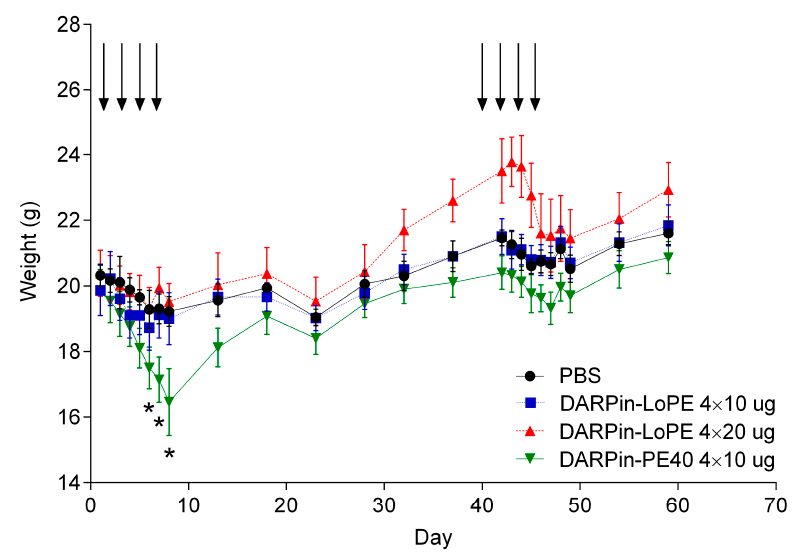
Figure 3. Mean weight of mice in different groups. The days of the targeted toxins injections are indicated with arrows (4 injections per course, 2 courses). PBS, mice treated with phosphate-buffered saline (control group); DARPin-LoPE 4 × 10 µg, mice treated with 10 µg DARPin-LoPE for 4 doses every other day (40 µg per course, 80 µg total); DARPin-LoPE 4 × 20 µg, mice treated with 20 µg DARPin-LoPE for 4 doses every other day (80 µg per course, 160 µg total); DARPin-PE40 4 × 10 µg, mice treated with 10 µg DARPin-PE40 for 4 doses every other day (40 µg per course, 80 µg total). The data are represented as mean ± SEM. “*” indicates a value that significantly differs from the respective control value at p < 0.05 (Student’s test with Bonferroni correction, n = 5).